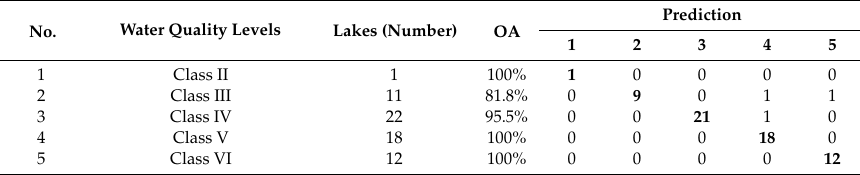
Table 7. The statistics of the prediction results for the water quality levels in each lake for the Wuhan